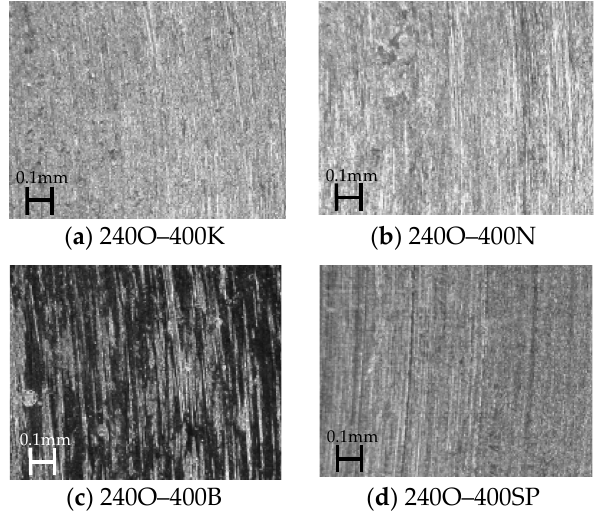
Figure 14. Steel sheet surface conditions.